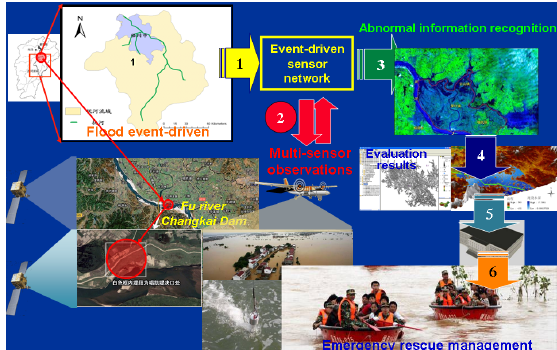
Figure 1: Event-driven observations in Fu river flood (June, 2010), Jiangxi province, P. R. China